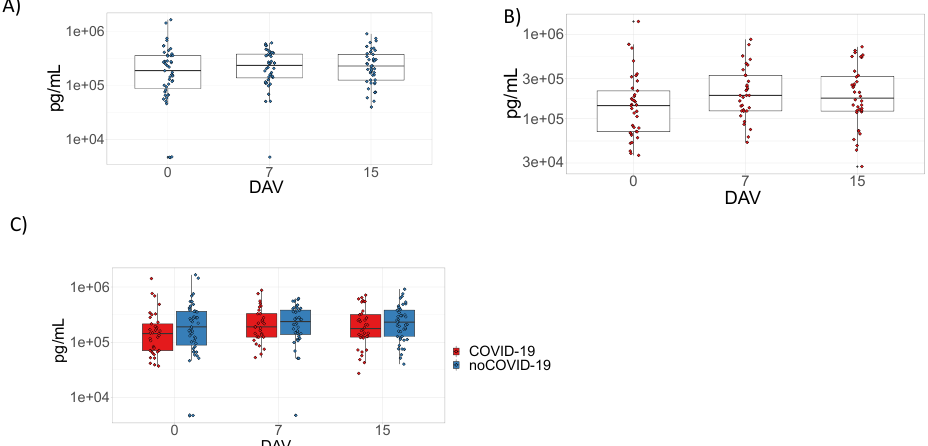
Figure 1. D-dimer plasma quantitation after ChAdOx1 nCoV-19 vaccination. Panels ( A – C ) refer to samples tested from volunteers immunized with the prime–boost protocols with ChAdOx1